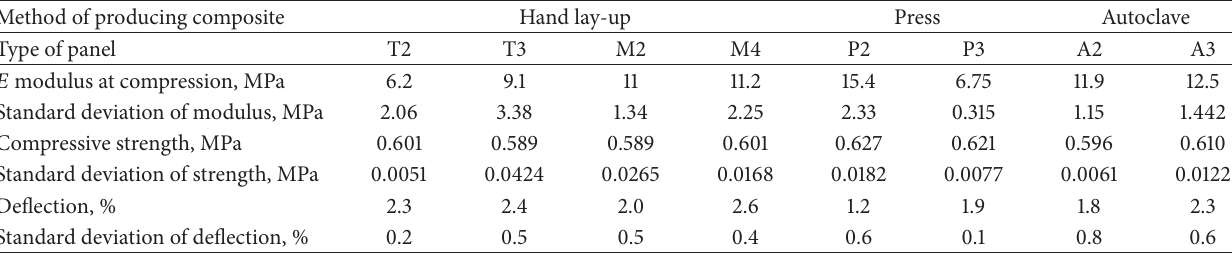
Table 3: Measurement results of compressive strength tests.